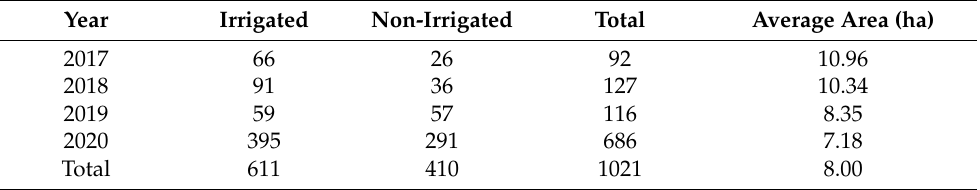
Table 1. Distribution of the number of in situ irrigated and non-irrigated plots for the four